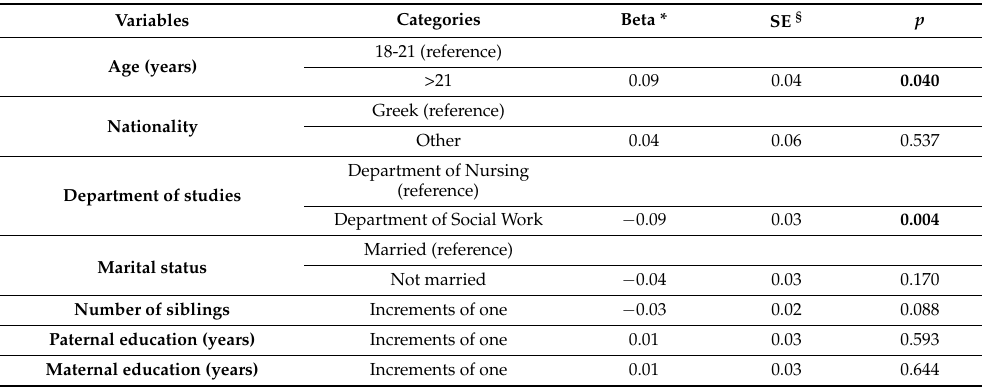
Table 7. Multivariate linear regression analysis of log-transformed knowledge scores about cervical cancer screening, in association with sociodemographic features; this analysis was confined to female students. Bold cells denote statistically significant associations.